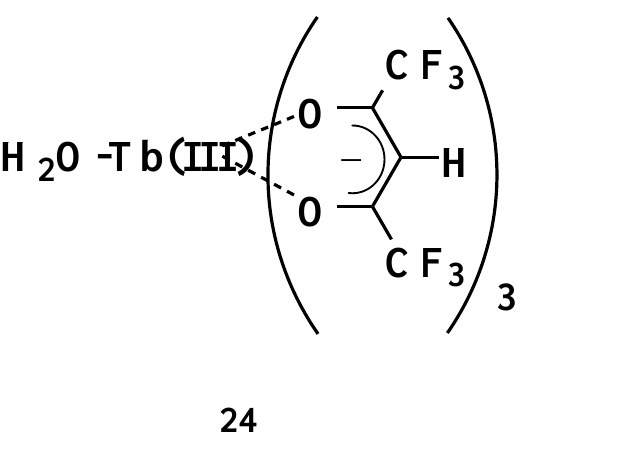
Figure 15. Molecular structures of Tb(III) complexes without phosphine oxide.